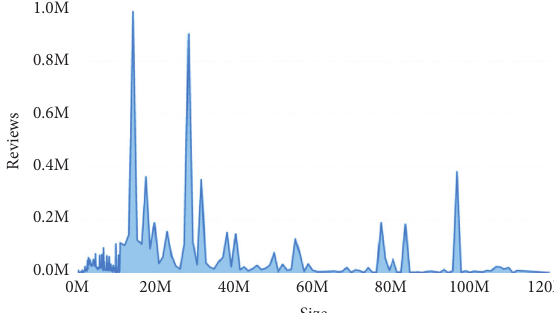
Figure 7: Relationship between app size and the number of reviews.